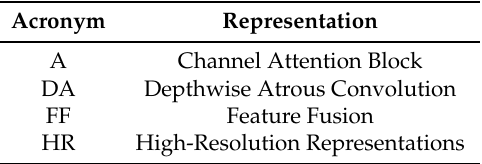
Table 2. Acronyms of our proposed deep learning